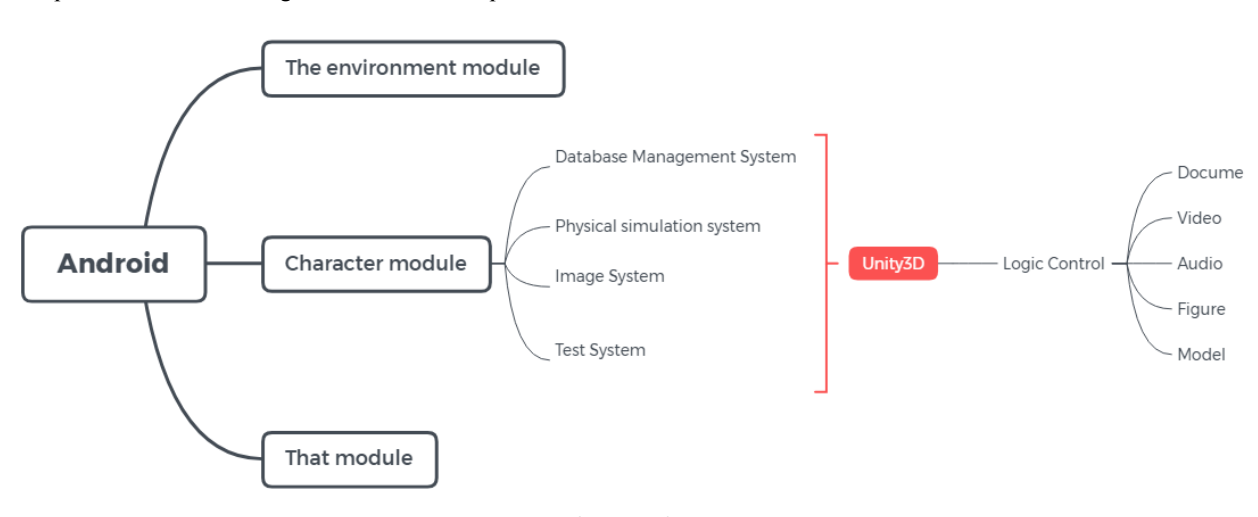
Figure 1. System frame diagram